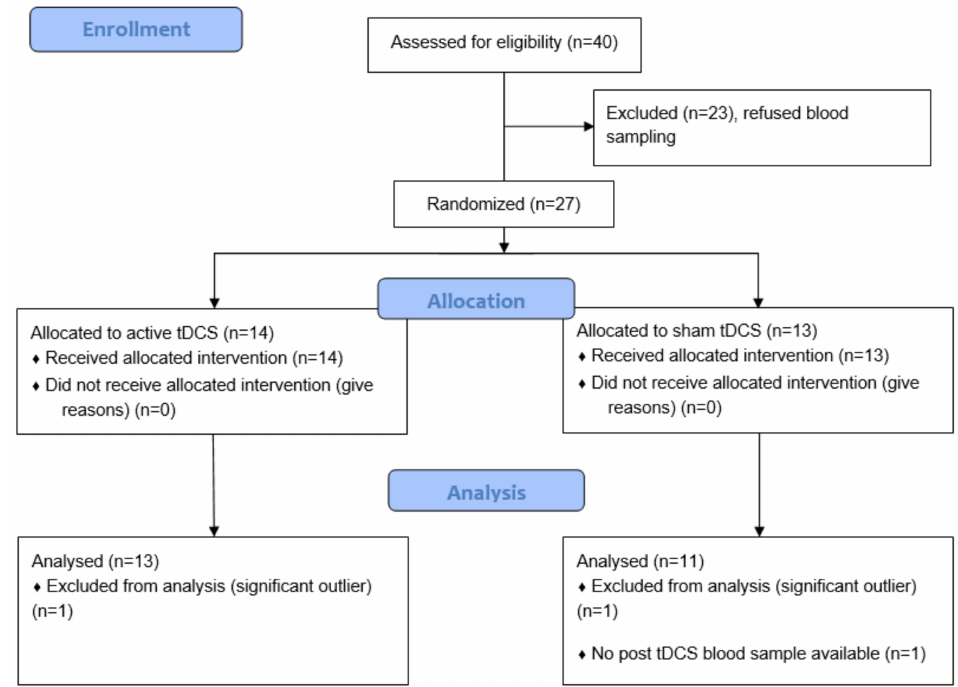
Figure 1. CONSORT flow diagram of the